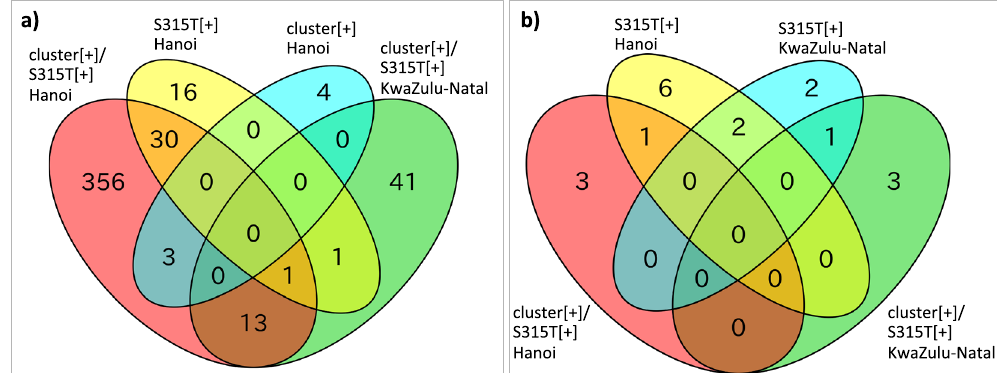
Figure 2. Venn diagram showing the number of genes significantly associated with the given phenotypes and shared by the two study cohorts. ( a ) results from k-mer-based GWAS; ( b ) results from phyOverlap; cluster[ + ]: clustered (pairwise SNV difference between two isolates is no more than five SNVs); S315T[ + ]: harboring katG - S315T mutation; Hanoi: Hanoi’s study cohort; KwaZulu-Natal: KwaZulu-Natal’s study